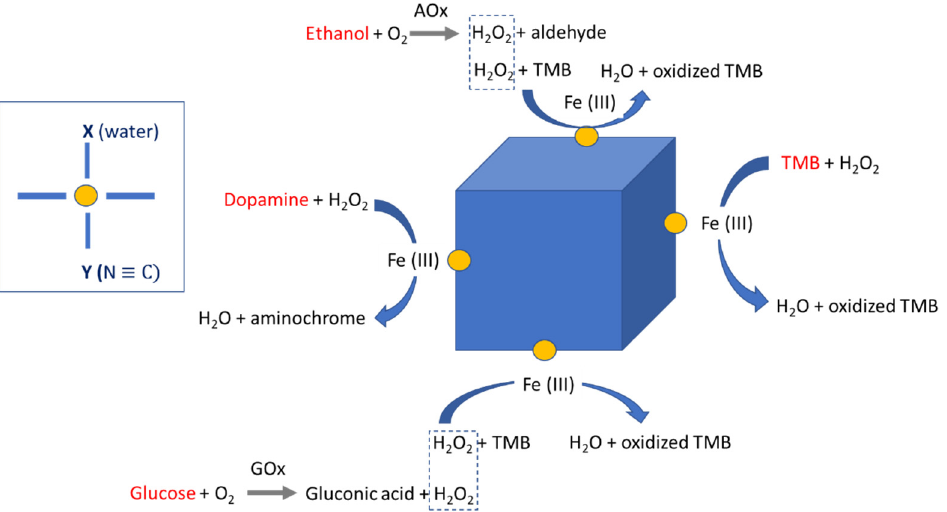
Figure 5. Reactions of the main analytes detected by using PB/PBA as POD-like nanozymes. Inside, the structure of FeNx band according to [42]; the blue bands represent the macrocyclic assembly of four N ≡ C in the same plane.